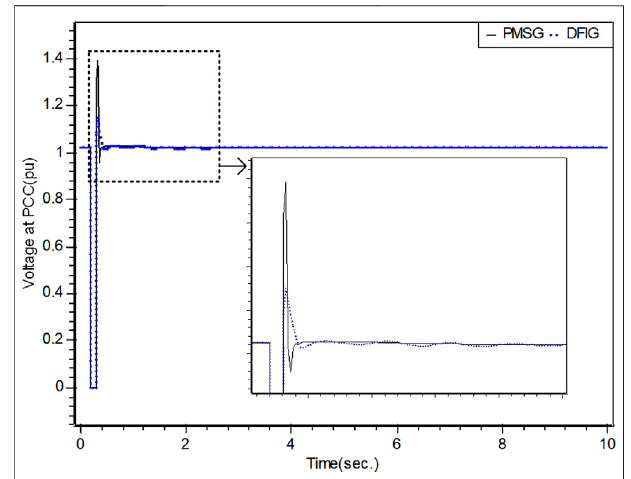
FIGURE 9 | Voltages at PCC of DFIG and